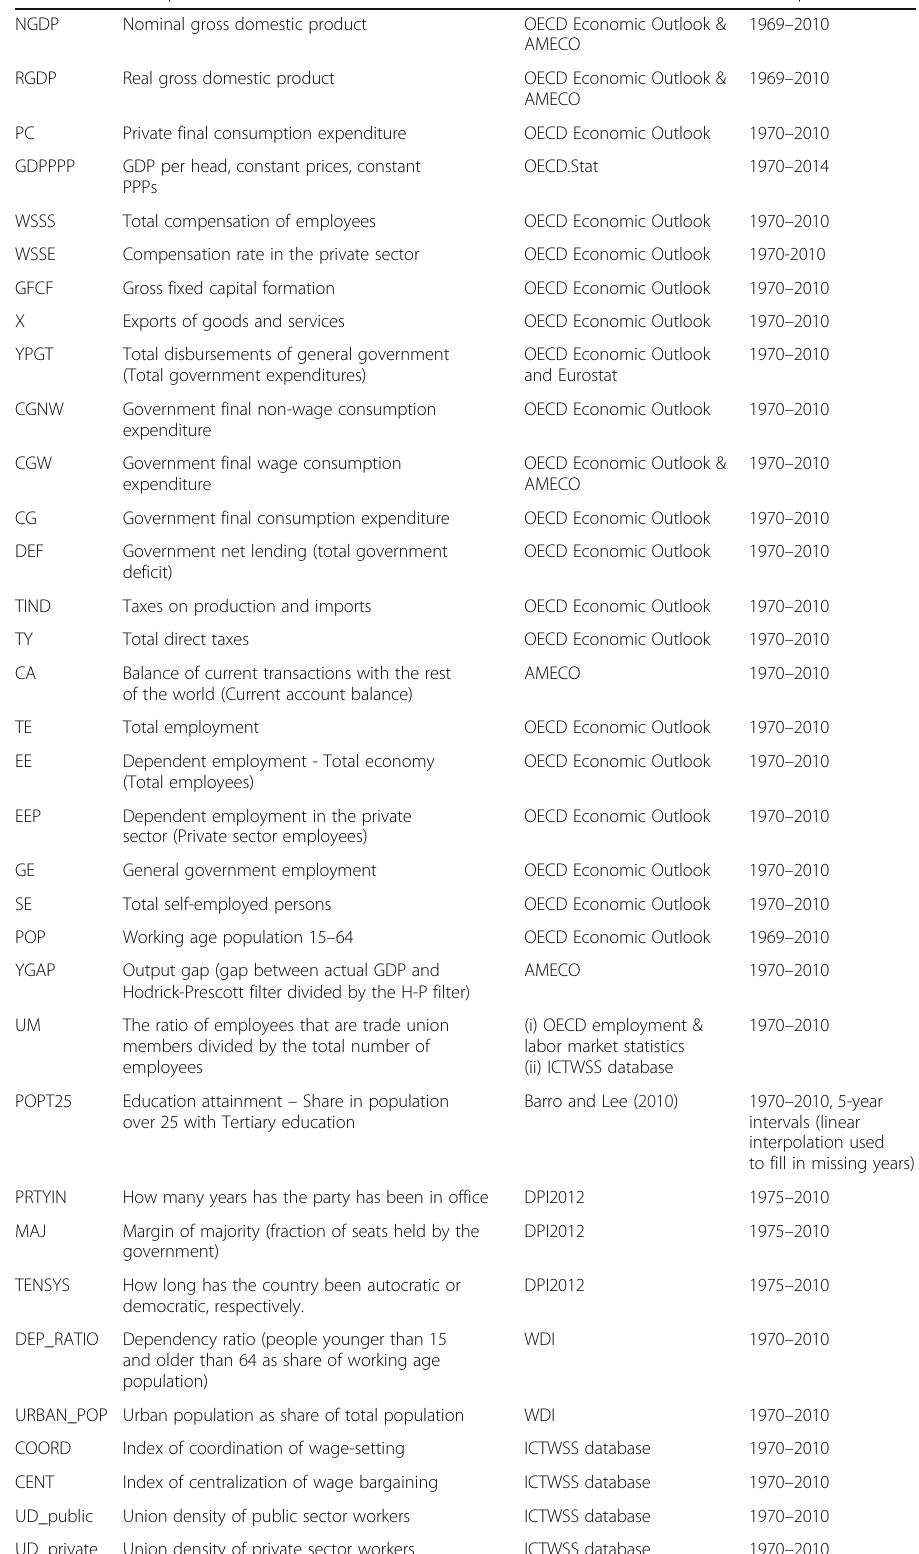
Table 23 List of macroeconomic and other